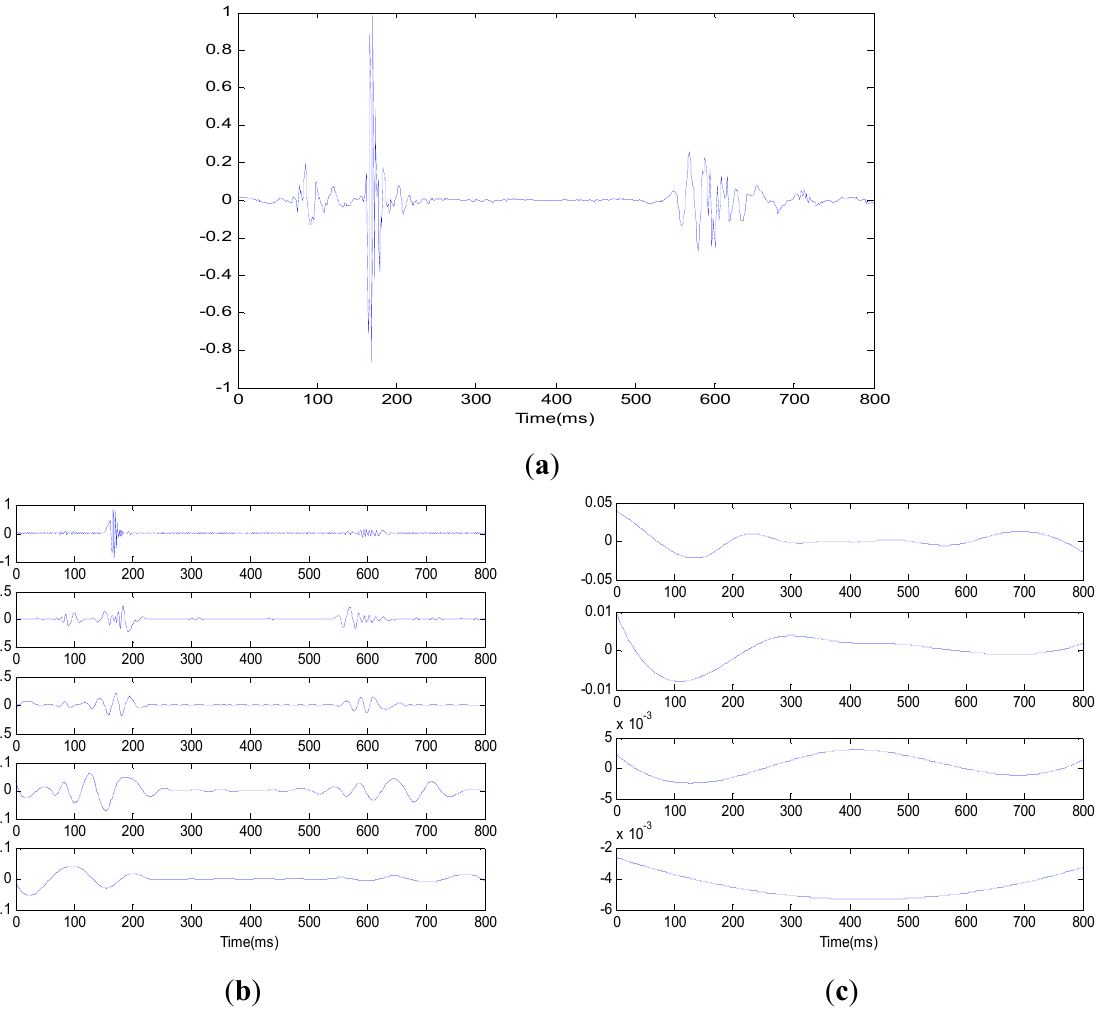
Figure 4. ( a ) Cardiac cycle of a heart sound signal; ( b ) First five IMF components of ( a )’s signal; ( c ) Last four IMF components of ( a )’s